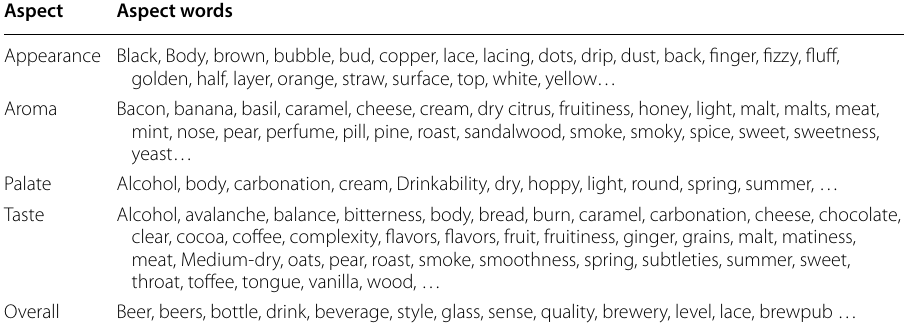
Table 9 Aspect word set of Beer data